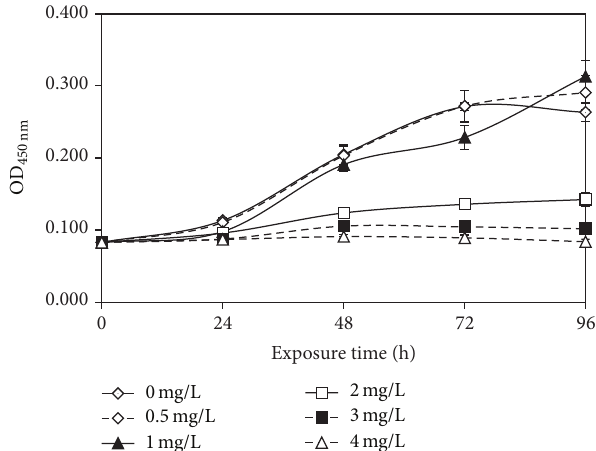
Figure 1: The effects of ethyl cinnamate on the biomass of Chlorella vulgaris . (The values represent the means ± 1 standard deviation and 𝑛 = 3